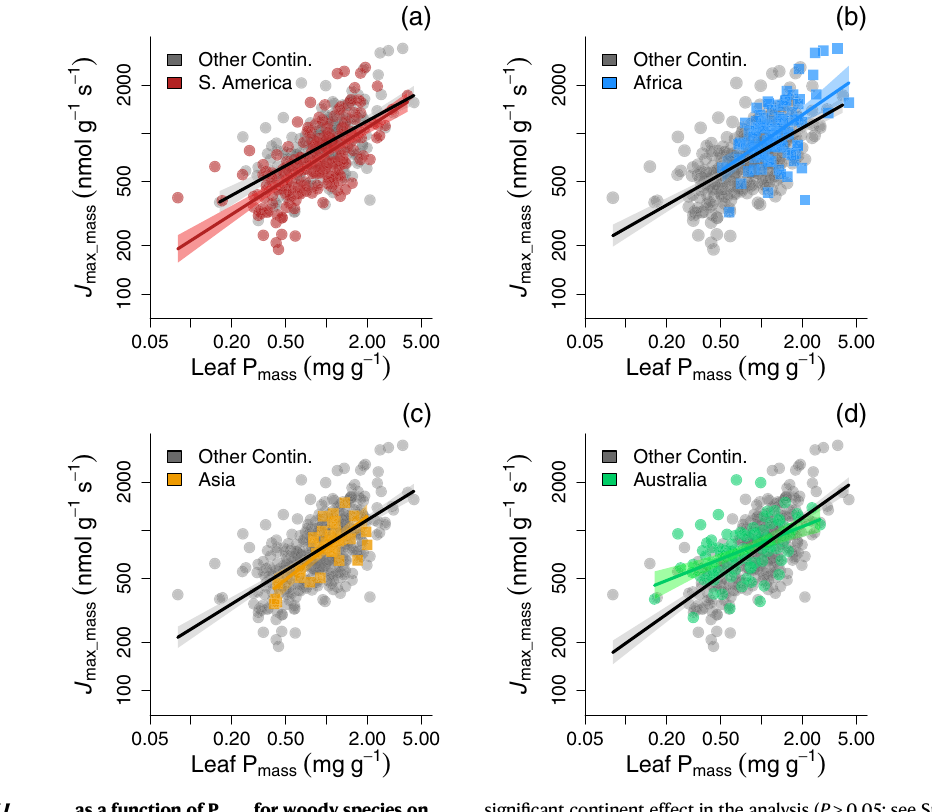
signi fi cant continent effect in the analysis ( P >0.05; see Supplementary Table 5). The 95% CI for each relationship around each line is shown in grey for ‘ Other Continents ’ , and the 95% CI for each continent is shaded in the corresponding colour for each continent being